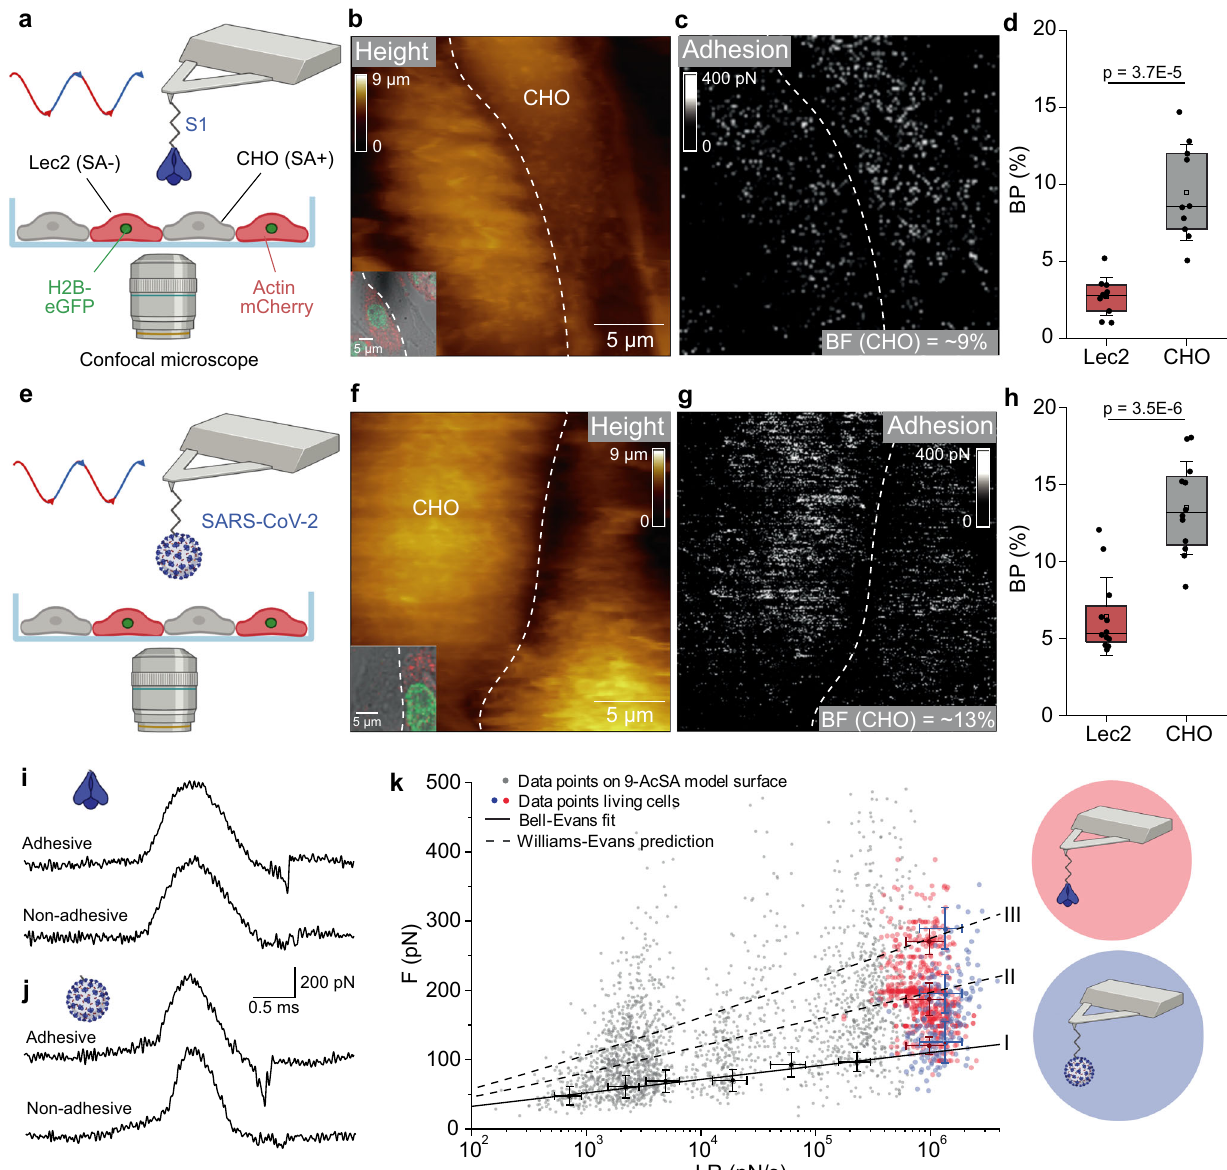
Fig. 3 Probing SARS-CoV-2 binding to SA on living cells. a , e Combined confocal microscopy and FD-based AFM assay of S1 ( a ) or SARS-CoV-2 ( e ) binding to cells expressing (CHO) or lacking (Lec2) SA on the cell surface. b , c , f , g FD-based AFM topography image ( b , f ) and corresponding adhesion map ( c , g ) from probing of adjacent cells (the inserts in b , f show the optical images of the probed area) with either S1 ( b , c ) or SARS-CoV-2 ( f , g ) functionalized AFM tips. Both adhesion maps show mostly interactions on CHO cells (SA-expressing cells) (white pixels). d , h Box plot of the BP between S1 and Lec2/ CHO cells ( d ) or SARS-CoV-2 and Lec2/ CHO cells ( h ). The square in the box indicates the mean, the colored box the 25th and 75th percentiles, and the whiskers the s.d. of the mean value. The line in the box indicates the median. N = 10 ( d ) or 12 ( h ) maps examined over three independent experiments. P values were determined by two-sample t test in Origin. i , j Force versus time curves showing either a non-adhesive curve (bottom) or speci fi c adhesive curves acquired for CHO and S1 ( i ) or SARS-CoV-2 ( j ) interaction. k DFS plot of data from acetylated SA model surfaces (grey circles, from Fig. 2e) and living cells (red dots: S1-tip, N = 655; blue dots: SARS-CoV-2-tip, N = 200). Data are representative of at least N = 12 cells from N = 4 independent experiments. Cartoons in panels a , e , i – k were created with BioRender.com. Source data in panels d , h , k are provided as a Source Data fi